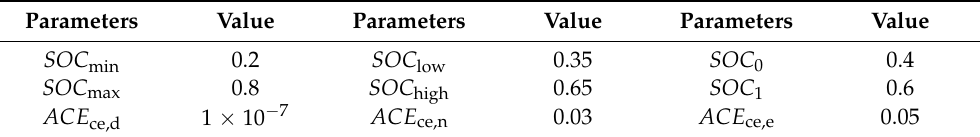
Table 2. Parameters of control rule.